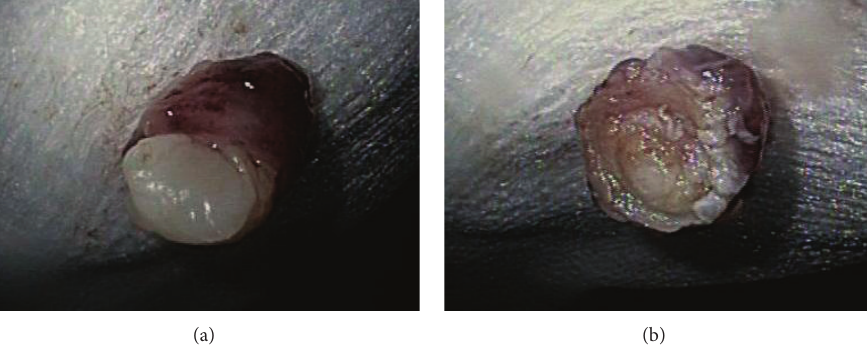
Figure 7: (a, b) 8mm firm nodule in the distal third/GE junction. It was removed via endoscopic mucosal